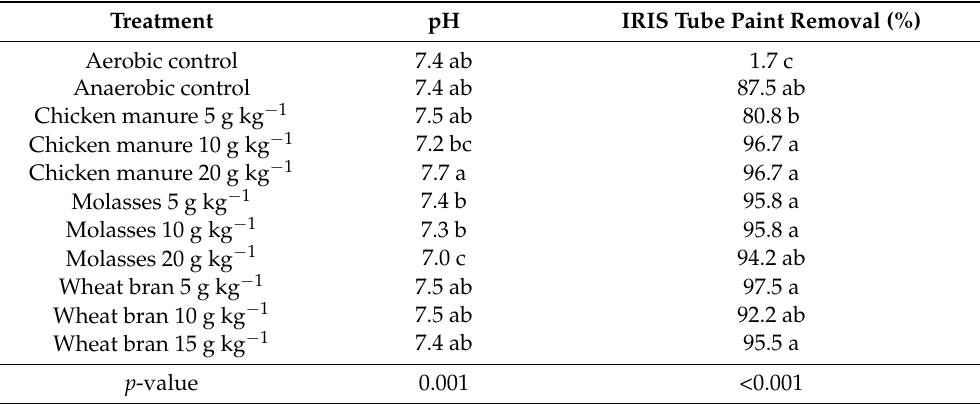
Table 5. Effects of anaerobic soil disinfestation (ASD) with different carbon sources rates on soil pH and iron oxide paint removal percent from Indicator of Reduction in Soils (IRIS) tubes under growth chamber conditions.